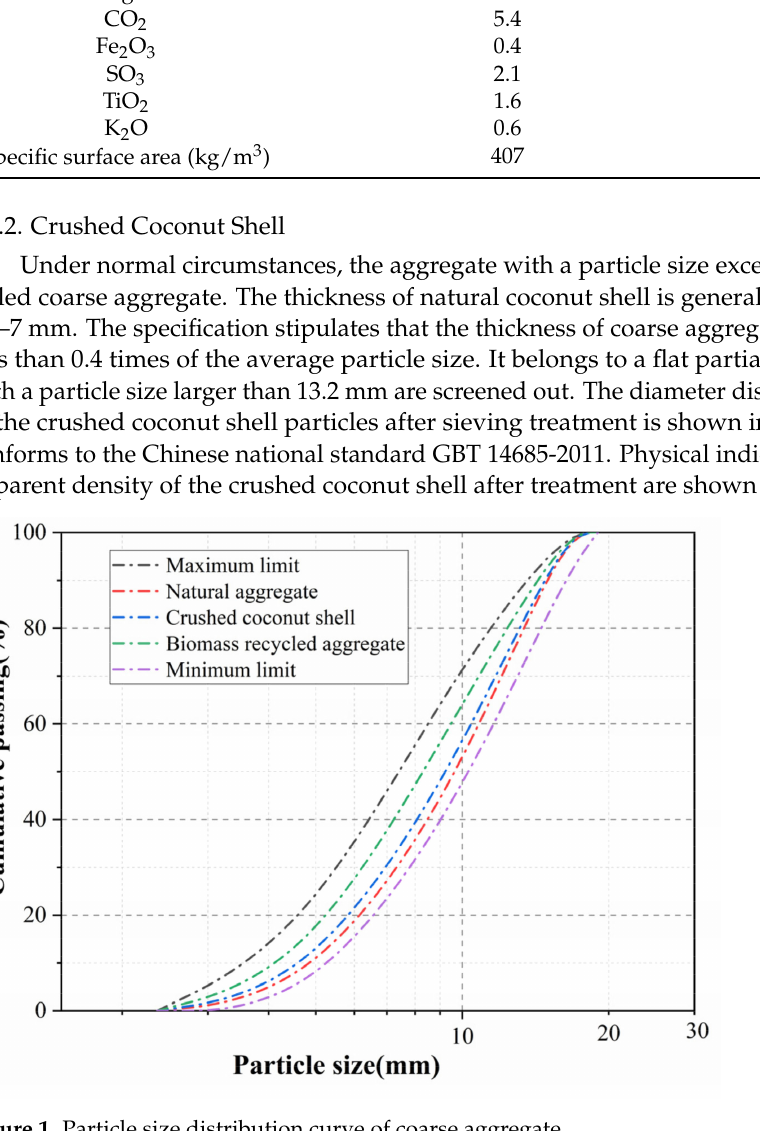
Figure 1. Particle size distribution curve of coarse aggregate. Table 2. Physical index of crushed coconut